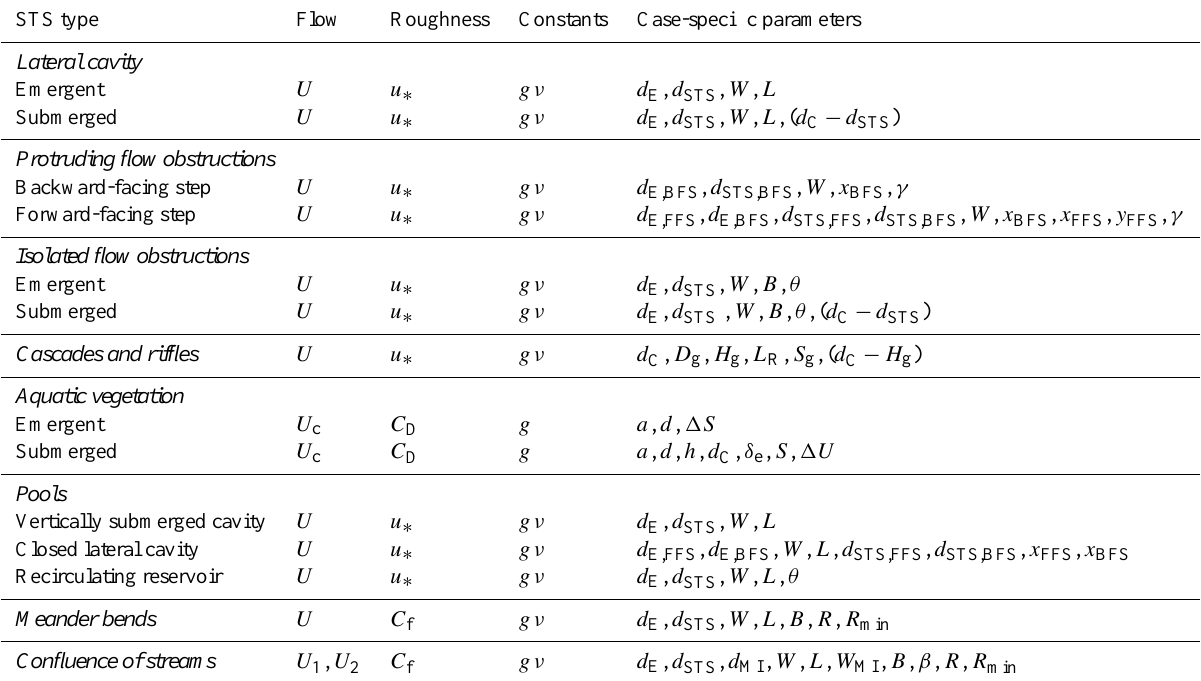
Table 3. Summary of hydromorphic parameters characteristic to STS